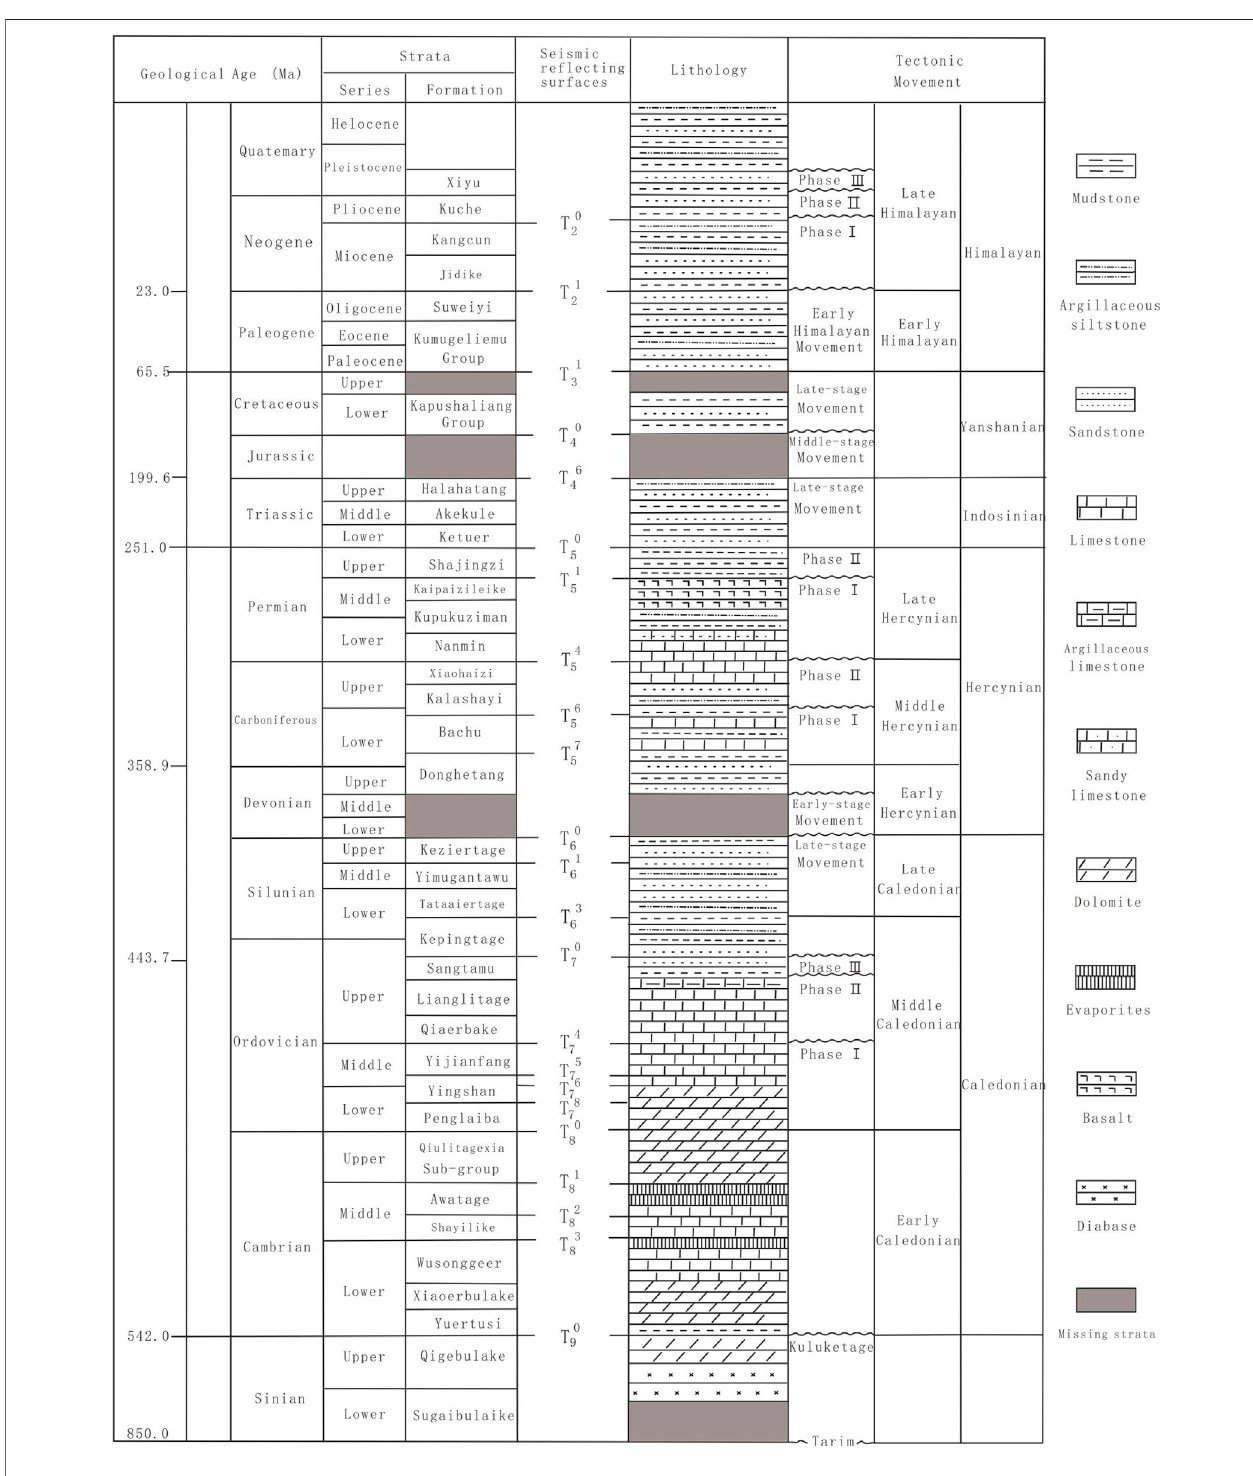
FIGURE 2 | Chart showing the Tarim Basin stratigraphy, the seismic re fl ecting surfaces, and timing of regionl tectonic movements.